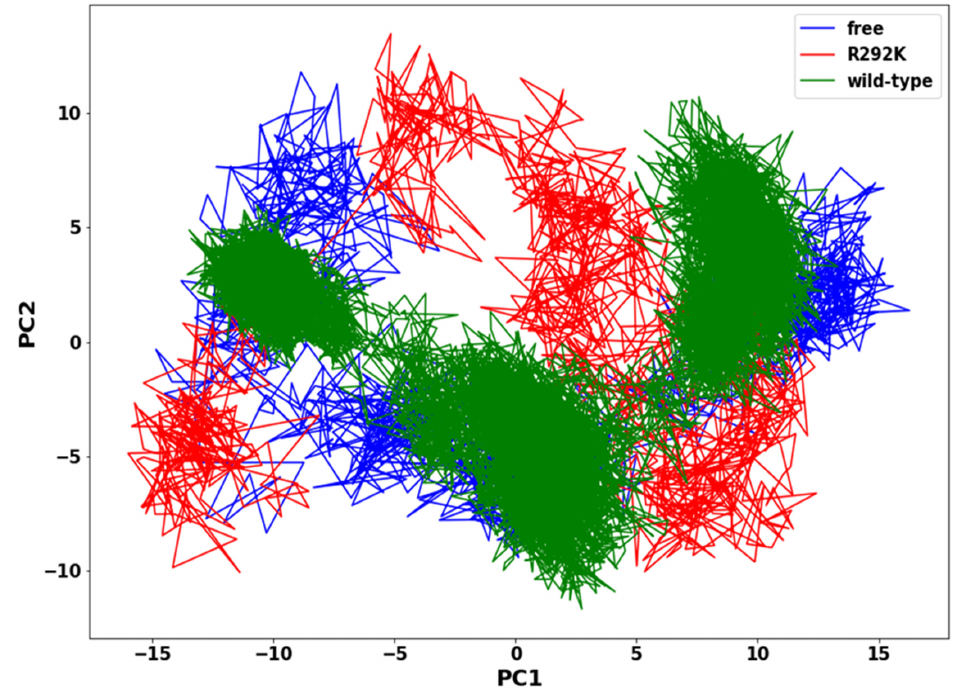
Figure 9. PCA scatter plot projection of C- α atoms motion of the first two principal components, PC1 and PC2, for peram- ivir-free neuraminidase and peramivir–wild-type and peramivir–R292K neuraminidase complexes conformations.